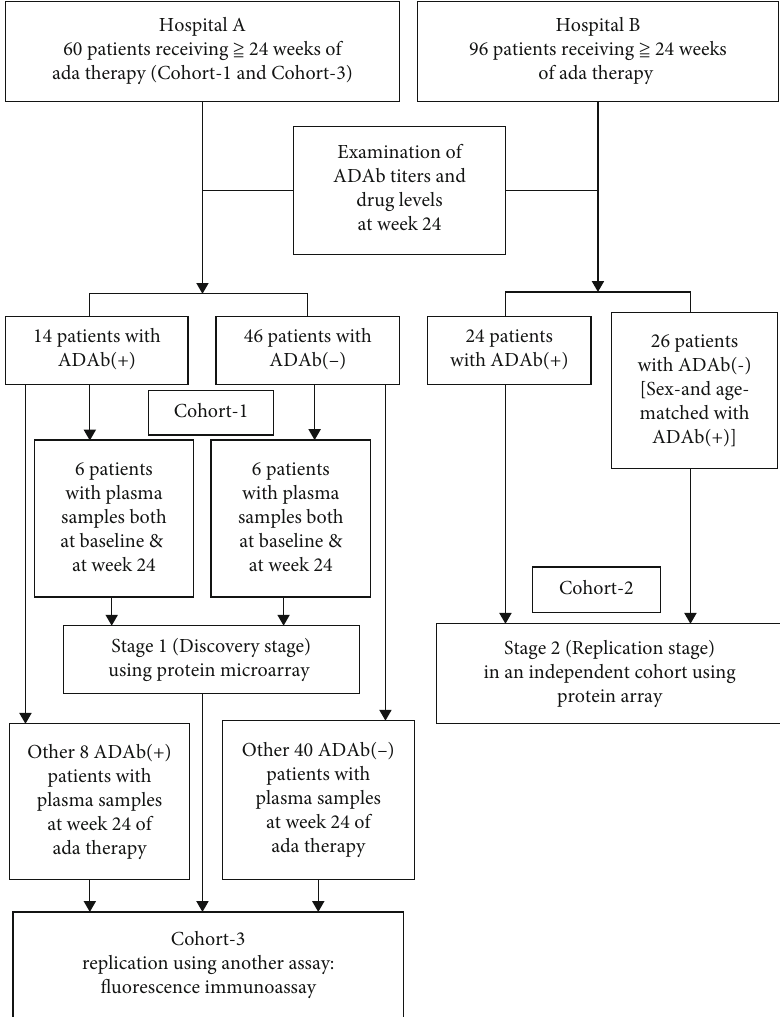
Figure 1: Study design and work fl ow. ADAb: anti-drug antibodies; ada: